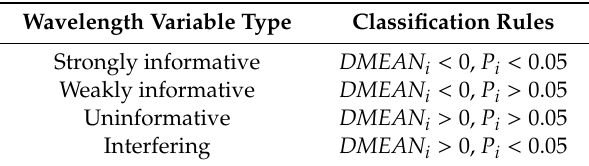
Table 1. Variable classification